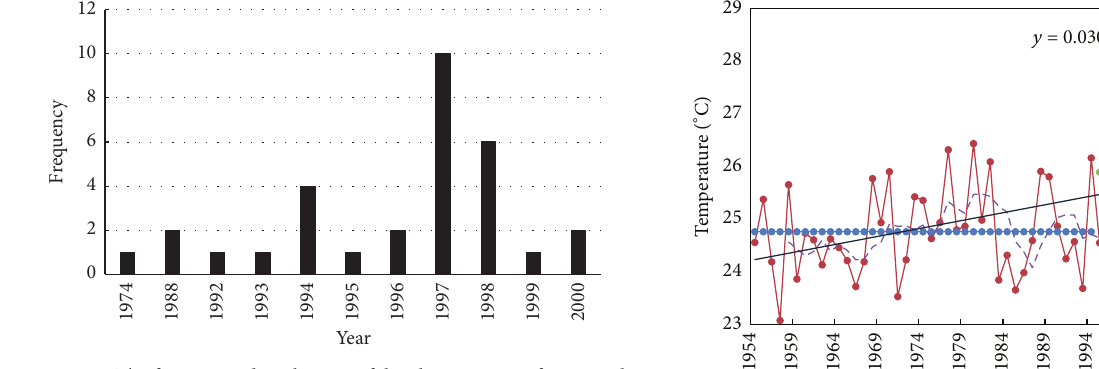
Figure6:Thefrequencydistributionofthechangepointsforannual maximum temperature in 44 stations.